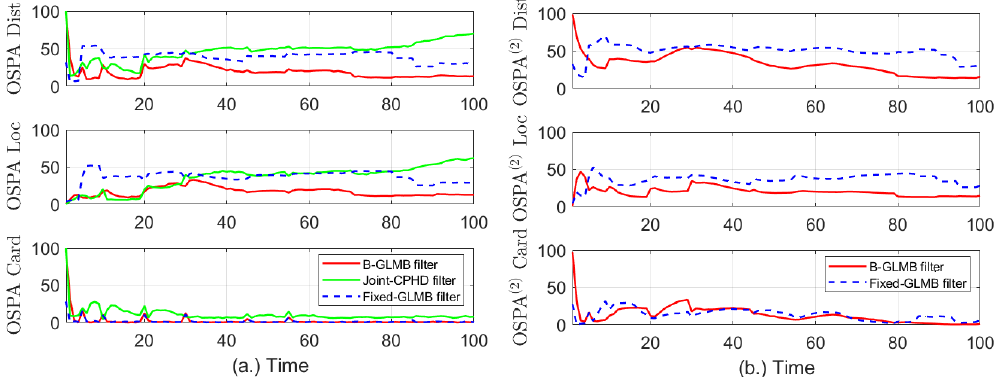
Figure 4. Evaluation of tracking errors using ( a ) OSPA, and ( b ) OSPA ( 2 )